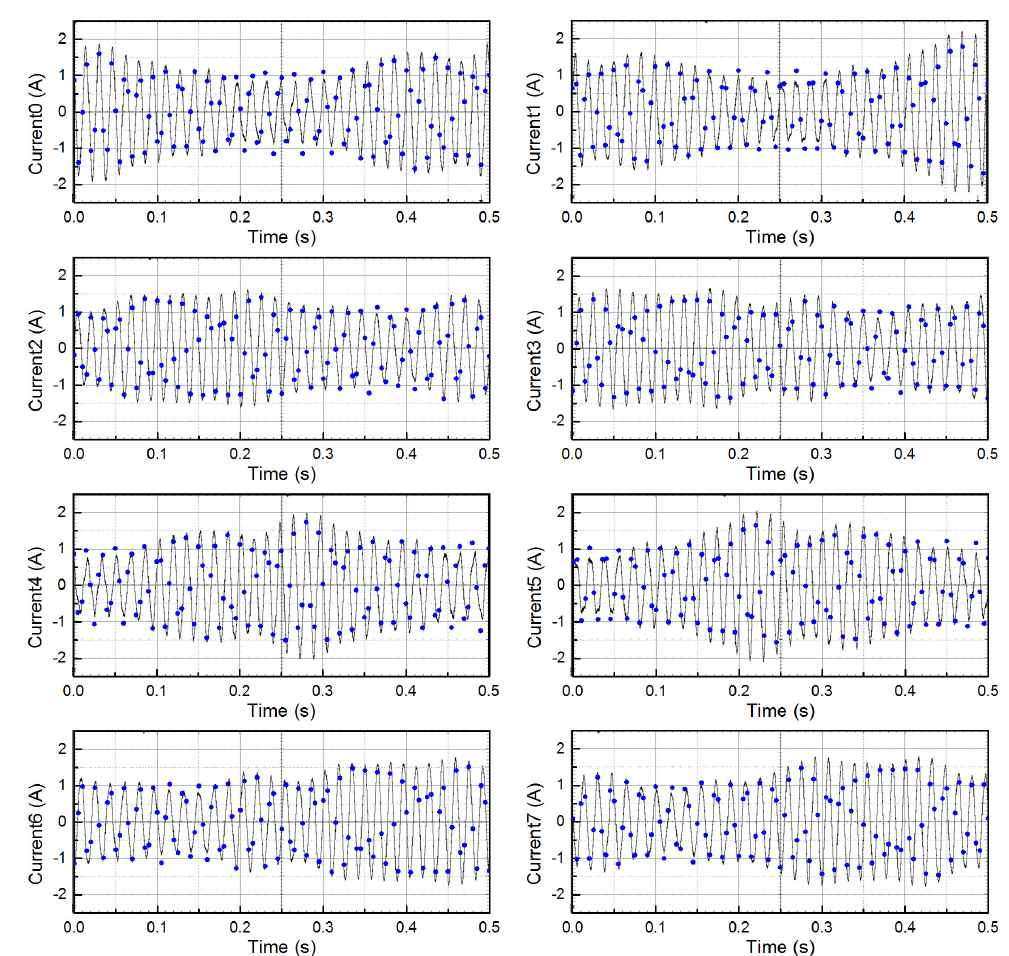
Figure 8. Current results of the proposed real-time current decoupling unit (line) and the off-line BEM simulation program